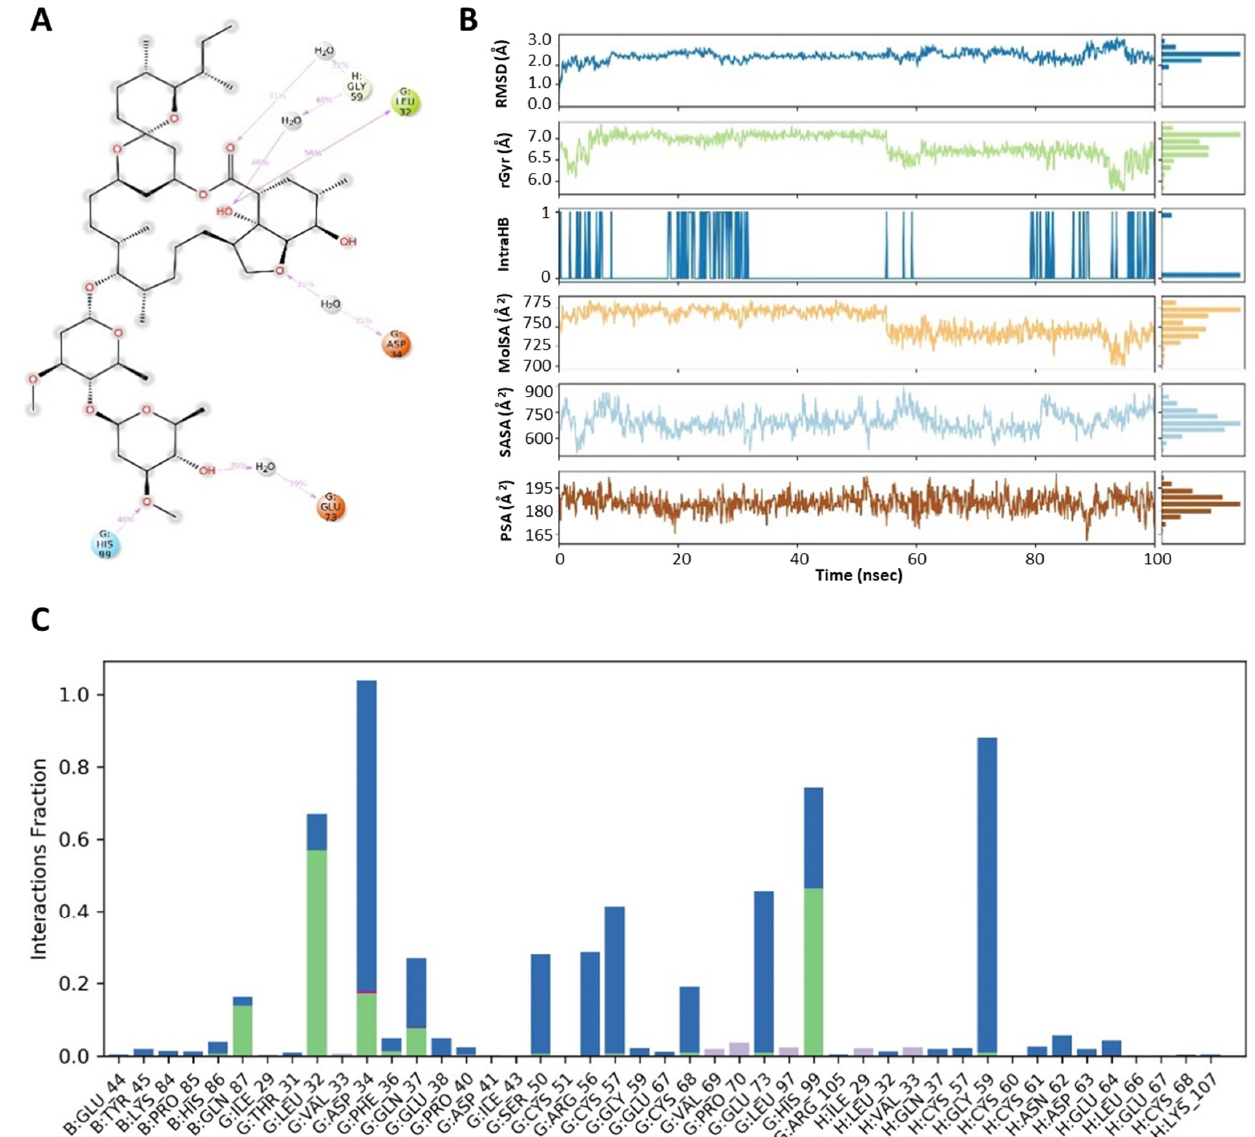
Figure 7. ( A ) Molecular interactions of ivermectin within pockets of VEGF receptor at specific sites. ( B ) Demonstration of ivermectin properties as ligand against VEGF receptor. ( C ) A histogram displaying the different types of interactions within ivermectin–VEGF complex. The values of RMSD, radius of gyration, molecular surface area, solvent accessible surface area and polar surface area are peaked and represented by the blue line, green line, orange line, cyan blue line and brown line,